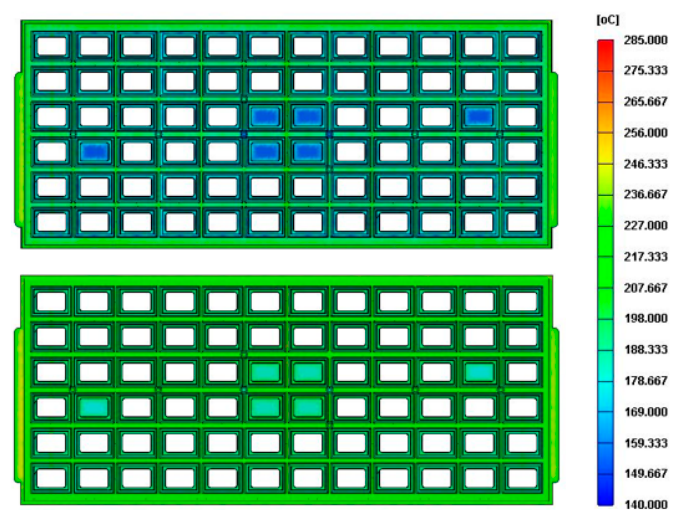
Figure 4. IC tray mold and injection molding machine.